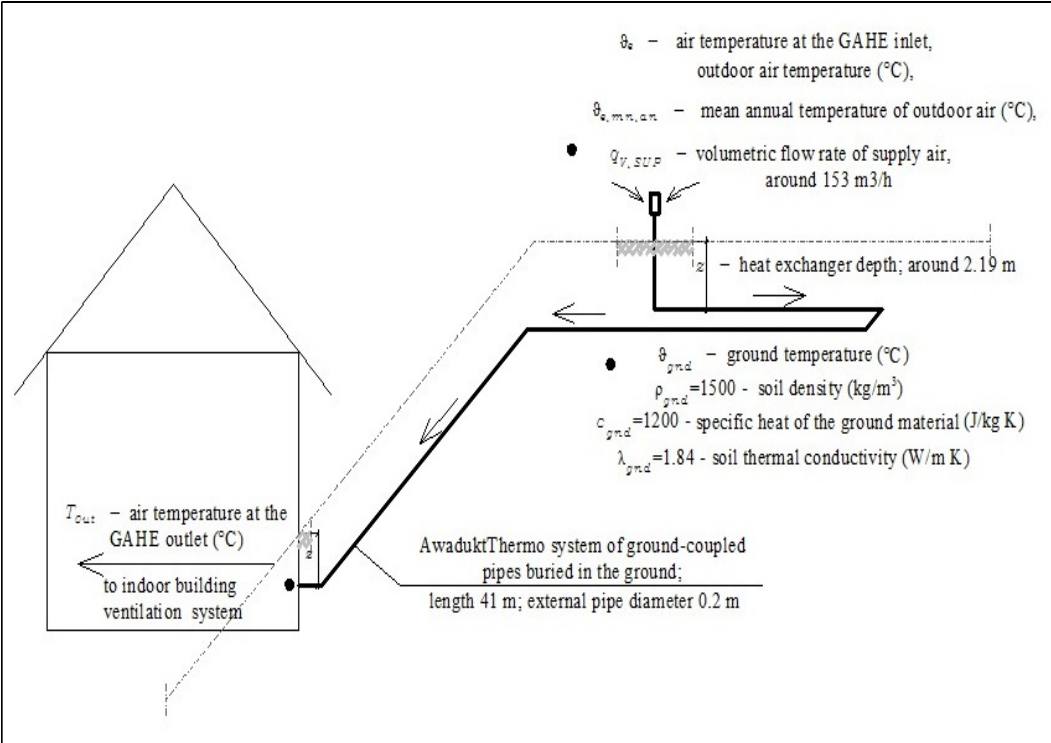
Figure 1. Diagram of the experimental setup.